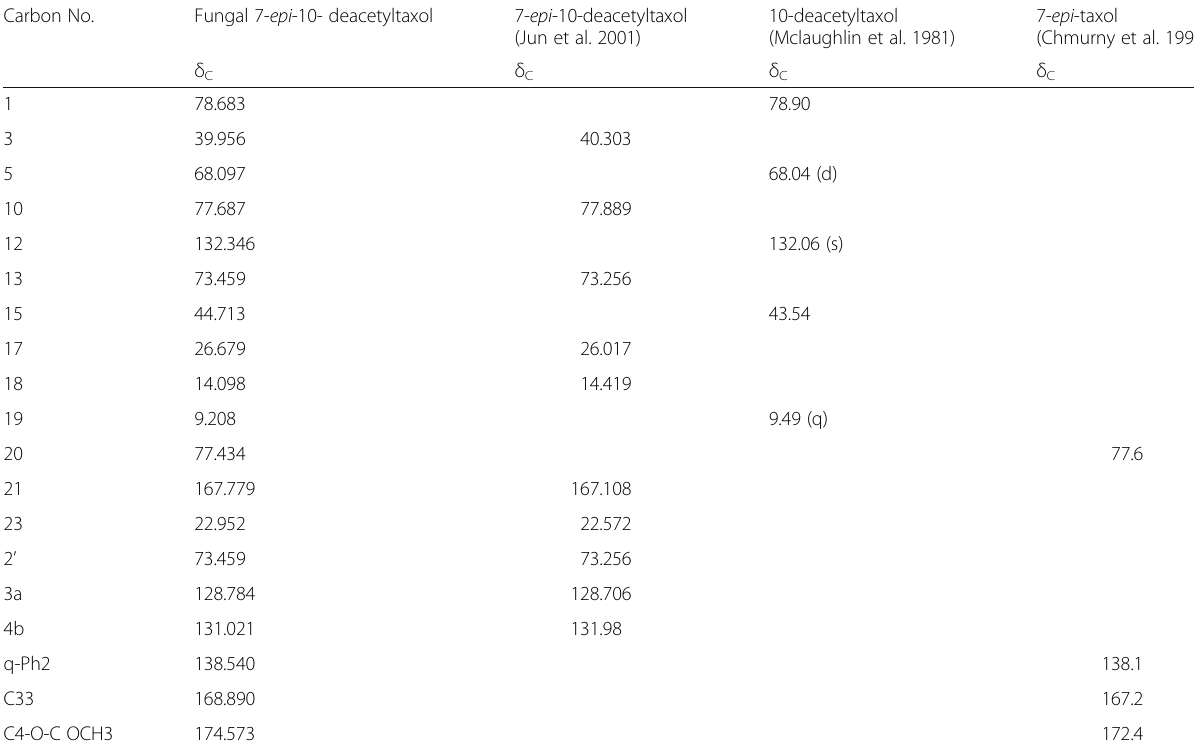
Table 2 Comparison of 13 C NMR data of fungal EDT with previously reported plant-derived 7- epi -10-deacetyltaxol, 10-deacetyltaxol and 7- epi -taxol chemical shifts ( δ ) and coupling constants ( J , Hz) Carbon